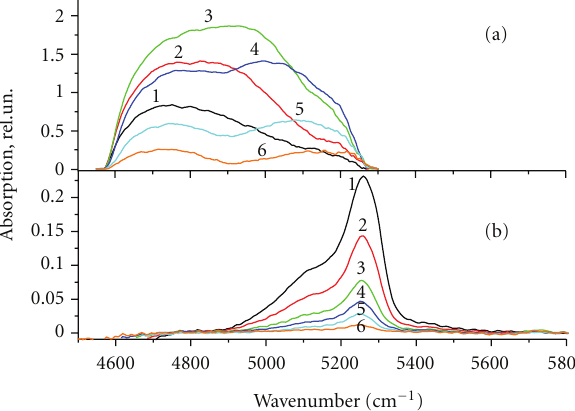
Figure 2: The absorption spectra of water microportions removed from SiO 2 with pores diameter of 12nm (a) and 50 nm (b) in the 4500–5800cm − 1 range, recorded at 10 (1), 20 (2), 30 (3), 40 (4), 50 (5), and 60 (6) min after the start of vacuum